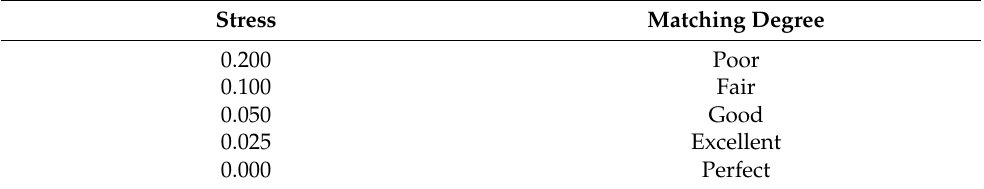
Table 1. Kruskal stress index